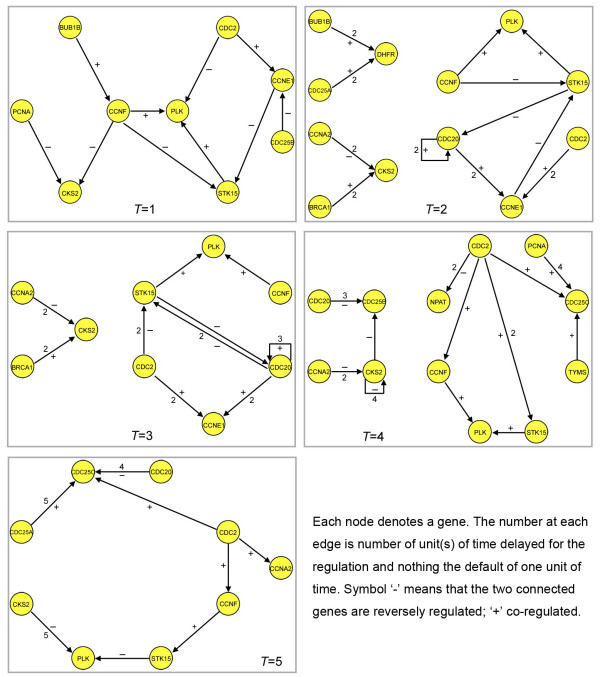
The time-delayed gene regulatory networks for the human HeLa cell cycling.